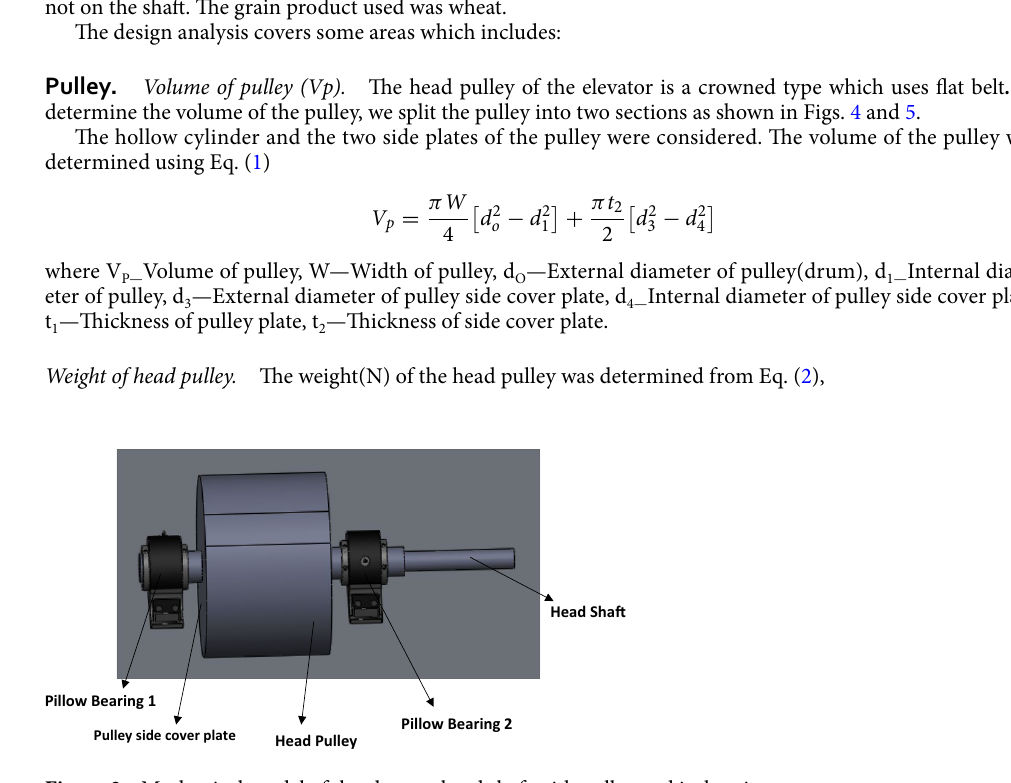
Figure 2. Mechanical model of the elevator head shaft with pulley and its bearing